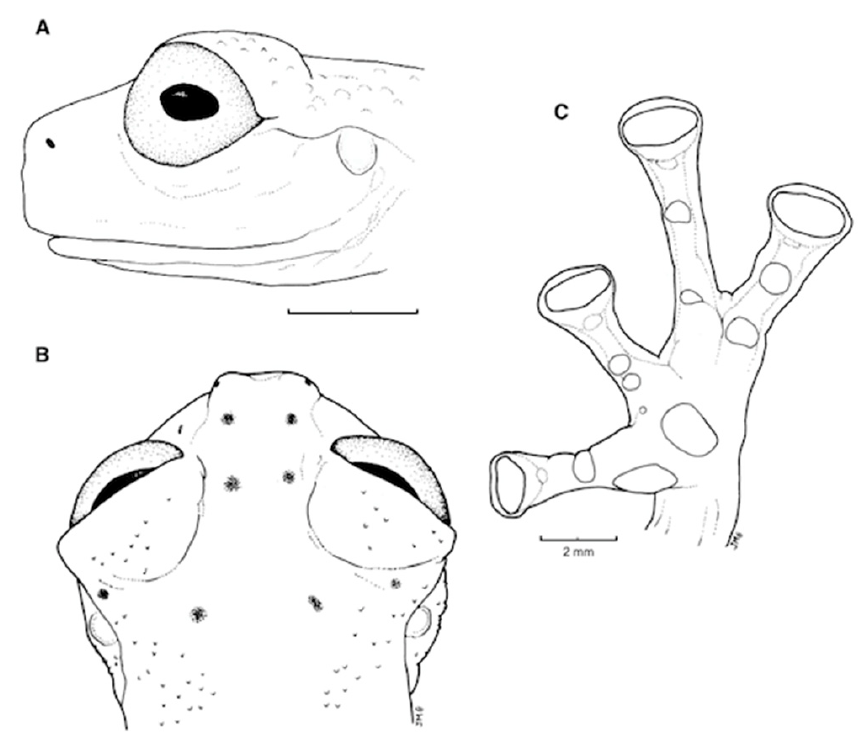
Figure 175. Nymphargus megacheirus , KU 143269. ( A ) Head in lateral view. ( B ) Head in dorsal view. ( C ) Hand in ventral view. Illustrations by Juan M. Guayasamin. Color in life (Figure 174): Dorsal surfaces green with small blue to black spots. Ventral surfaces mostly white, except for translucent posterior third of venter. Upper lip and ulnar folds white. Bones green. Iris greyish bronze